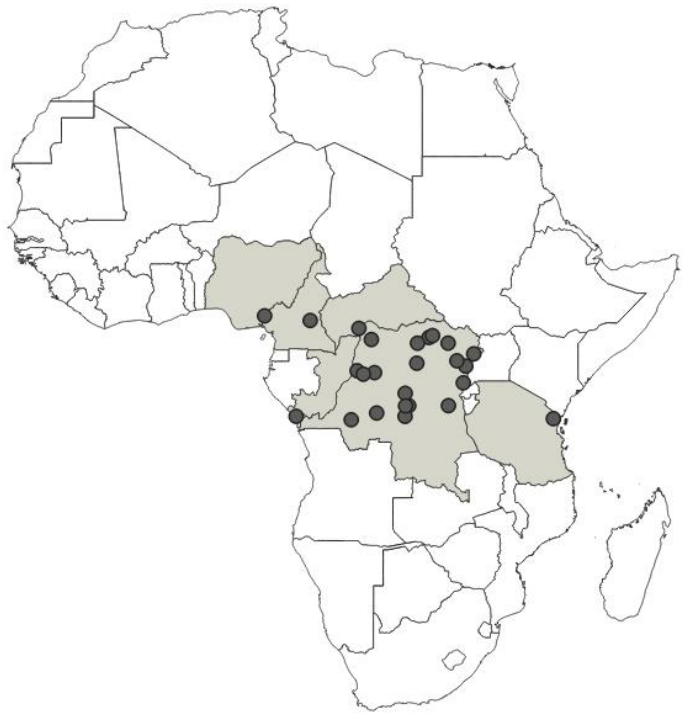
Figure 37. Known distribution of Phonoctonus elegans Varela, 1904.